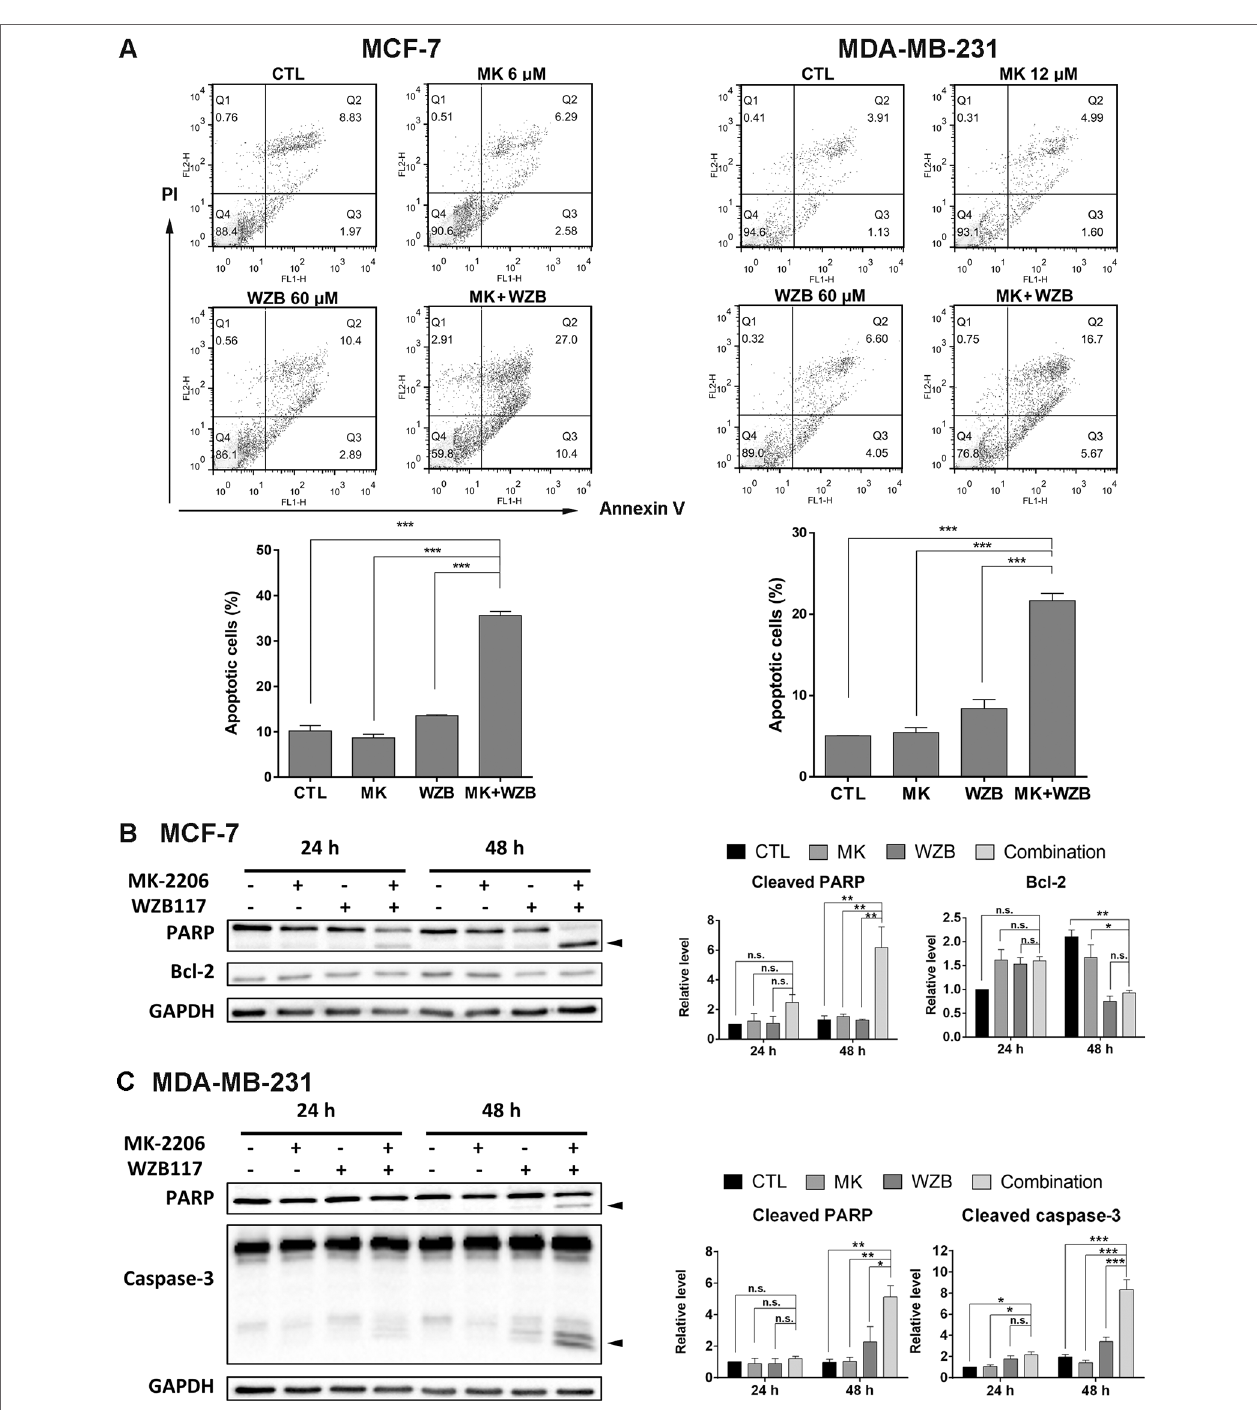
FIGURE 3 | MK-2206 and WZB117 synergistically induce apoptosis in MCF-7 and MDA-MB-231 cells. (A) Annexin V-FITC/PI staining and flow cytometric analysis. Cells were treated with 6 or 12 μM of MK-2206 and 60 μM of WZB117 either alone or in combination for 48 h. Representative dot plots and quantitative data from three independent experiments showed that MK-2206 and WZB117 significantly induced apoptosis. (B) Western blot analysis of proteins involved in apoptosis in MCF-7 cells. Cells were treated with 6 μM of MK-2206 and 60 μM of WZB117 either alone or in combination for 24 or 48 h. (C) Western blot analysis of proteins involved in apoptosis in MDA-MB-231 cells. Cells were treated with 12 μM of MK-2206 and 60 μM of WZB117 either alone or in combination for 24 or 48 h. Quantitative data are presented as the mean ± SEM of three independent experiments. Cleaved PARP and caspase-3 are marked with arrowheads . * P < 0.05; ** P < 0.01; *** P < 0.001; n.s., not significant (P >